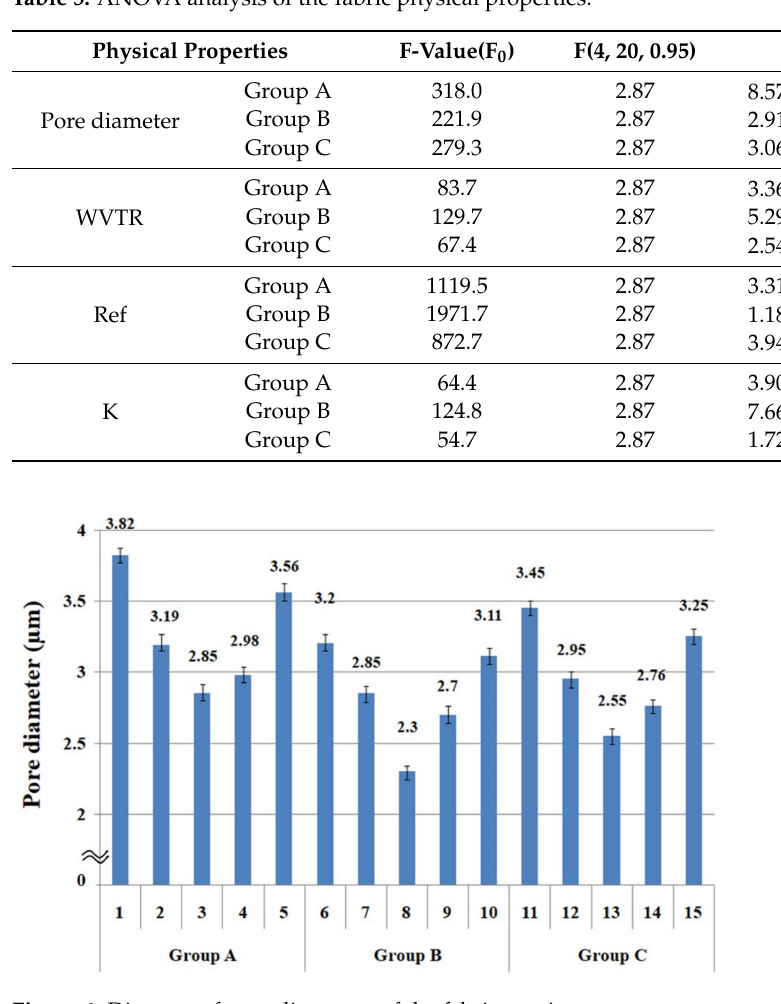
Figure 4. Diagram of pore diameters of the fabric